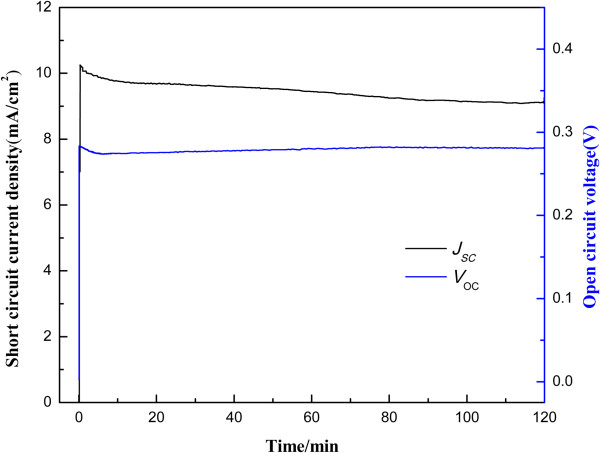
Photostability of Ag2S QD-sensitized solar cell under AM 1.5 illumination at 100 mW/cm2.